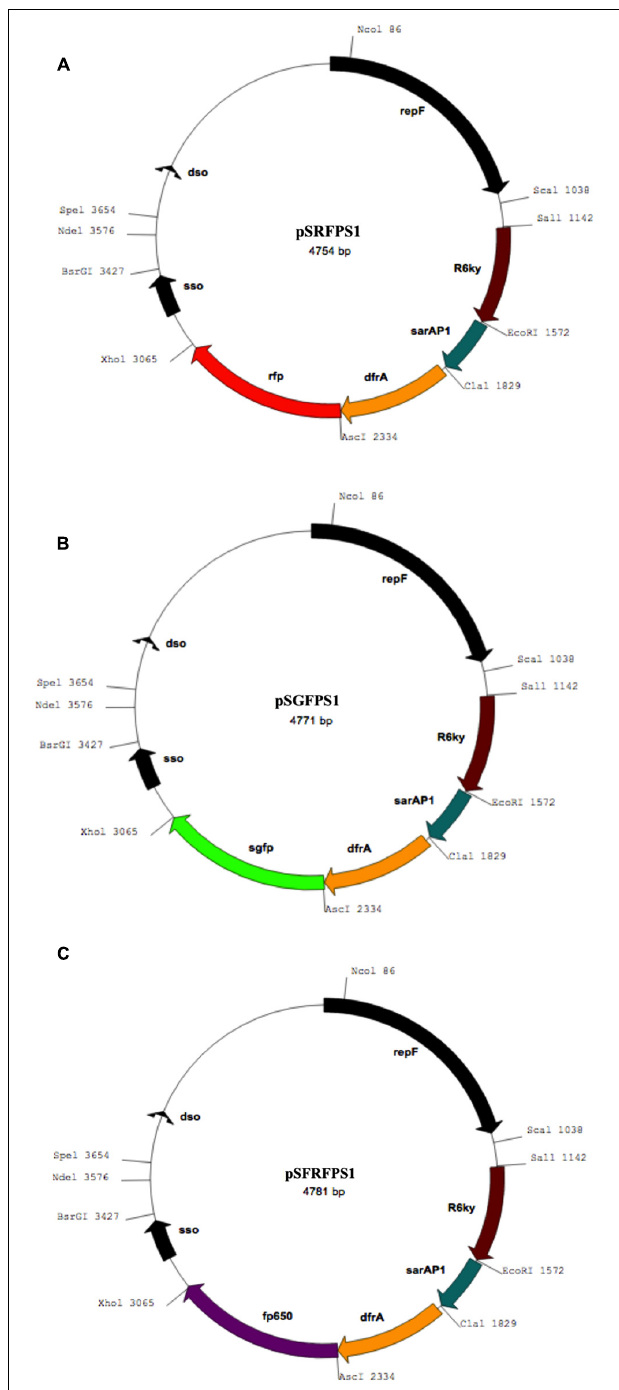
FIGURE 1 | Maps of recombinant plasmids containing genes coding for (A) red (pSRFPS1), (B) green (pSGFPS1), and (C) far-red (pSFRFPS1) fluorescent